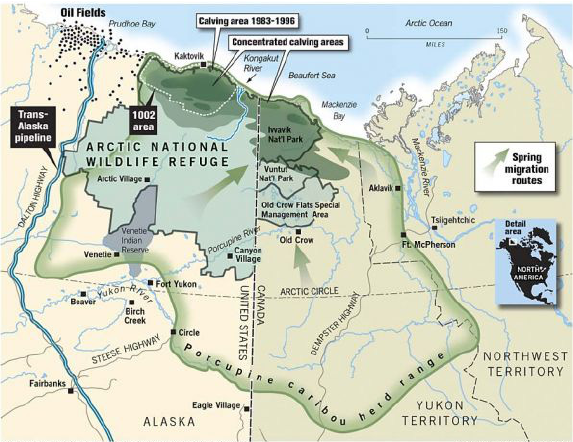
Figure 1 The Porcupine Caribou Herd and the Border between Alaska and the Yukon Territory